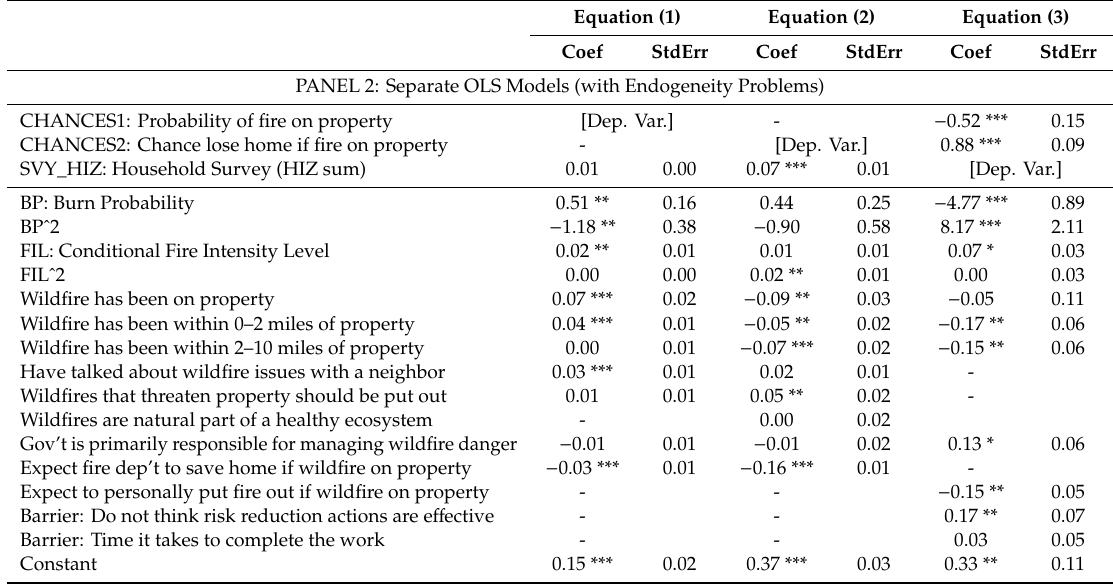
Table 5. Cont. Equation (1) Equation (2) Equation (3) Coef StdErr Coef StdErr Coef StdErr PANEL 2: Separate OLS Models (with Endogeneity